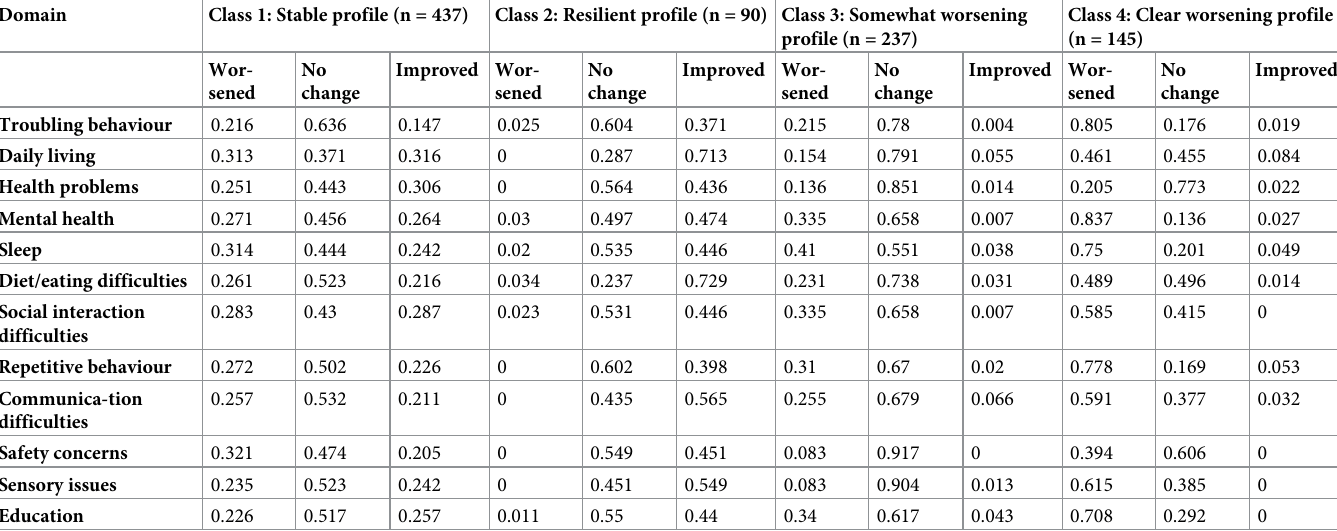
Table 3. Response profiles (i.e., classes) derived from the latent class analysis with probability of response for each domain. Domain